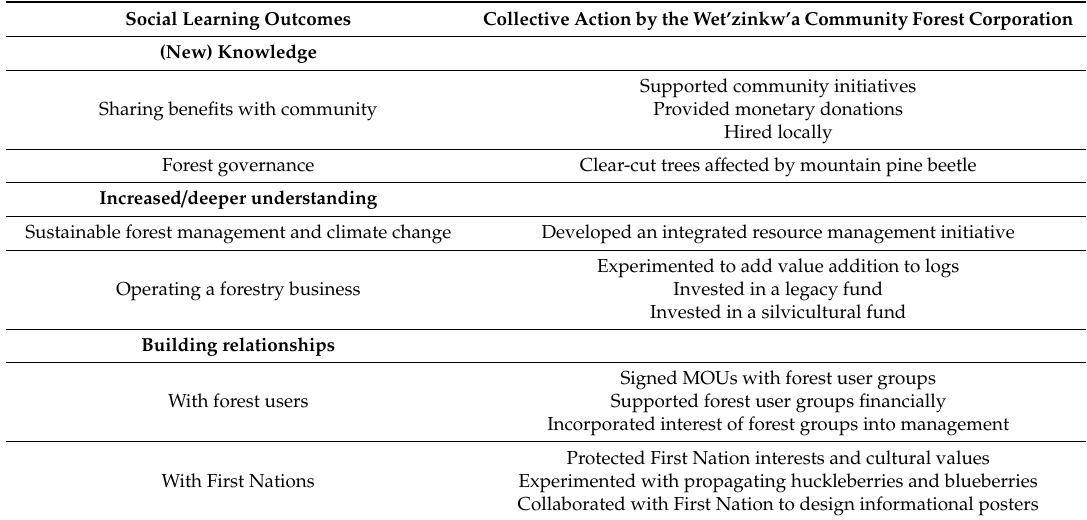
Table 1. Social learning outcomes and associated collection action